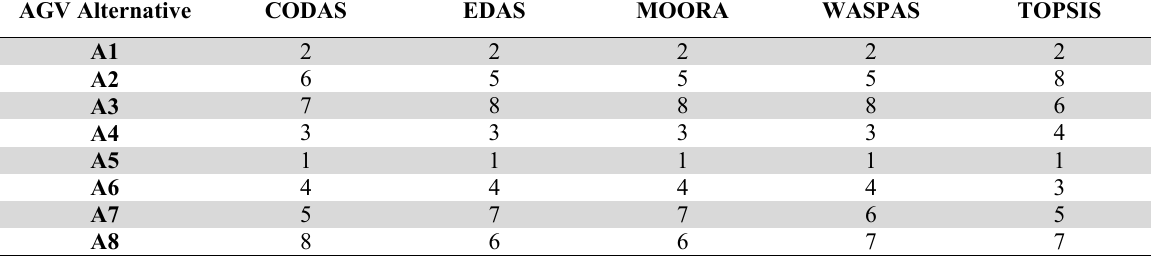
Ranking obtained by various MCDM methods for AGV selection problem AGV Alternative CODAS EDAS